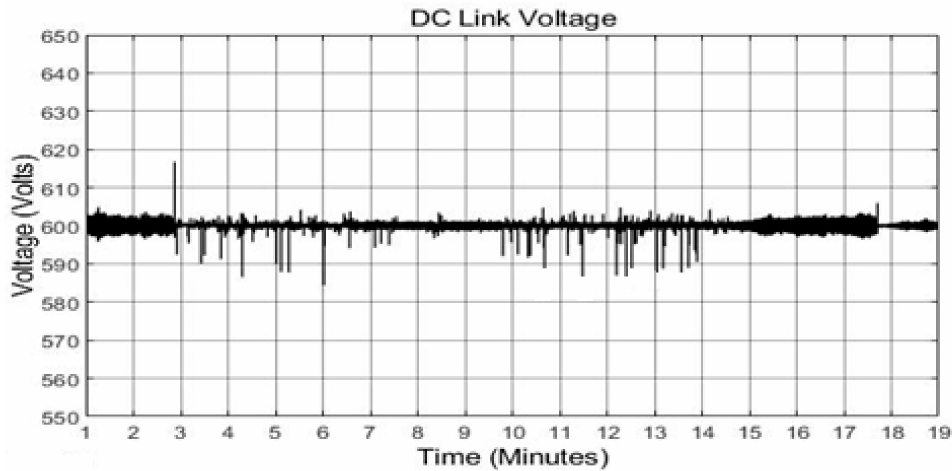
Figure 22. DC link voltage for load profile 1 with flywheel.